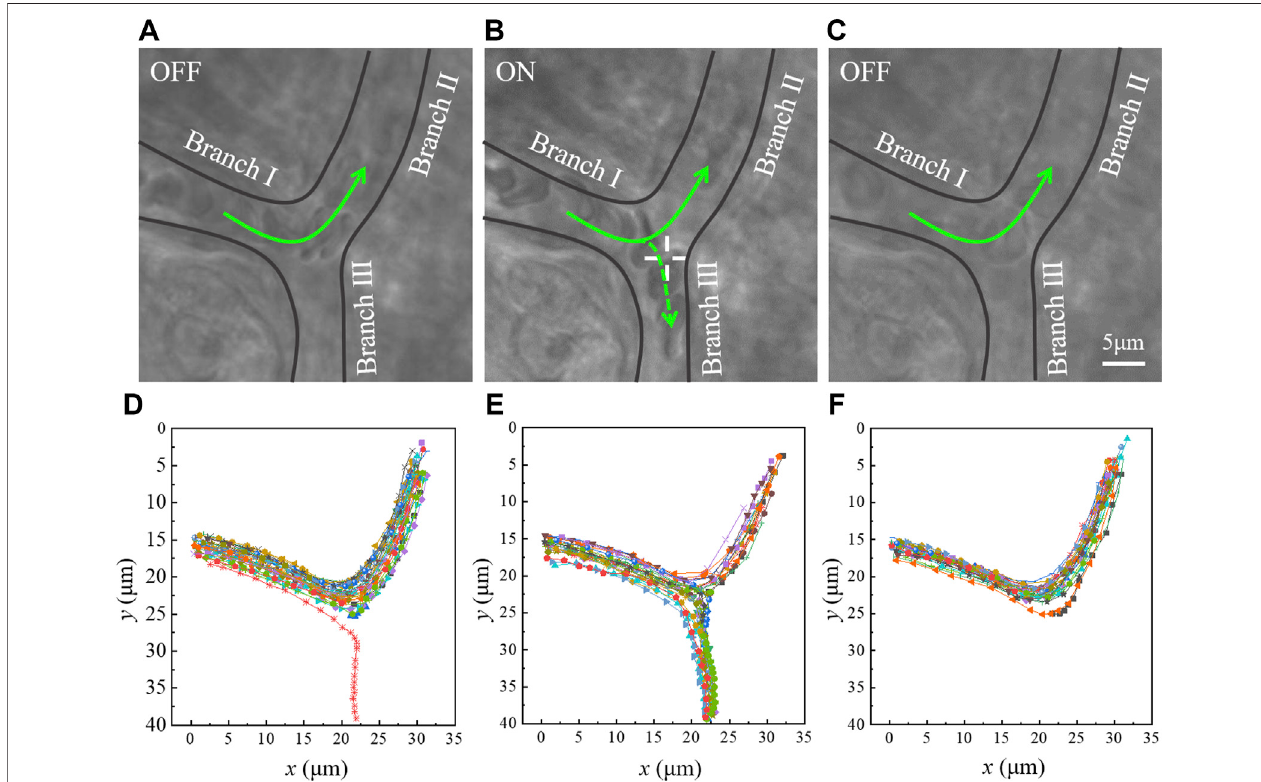
FIGURE 2 | Dynamic reperfusion of the microvascular blood fl ow by optical tweezers. The laser is (A) off ( Supplementary Video S1 ), (B) on ( Supplementary VideoS1 ),and (C) off ( Supplementary VideoS1 ). ‘ + ’ indicates the optical trap. (D – F) Pathtracing ofthe RBCs. The points record the position coordinates ofRBCsin each frame of the images, and each curve represents the fl owing path of an RBC.